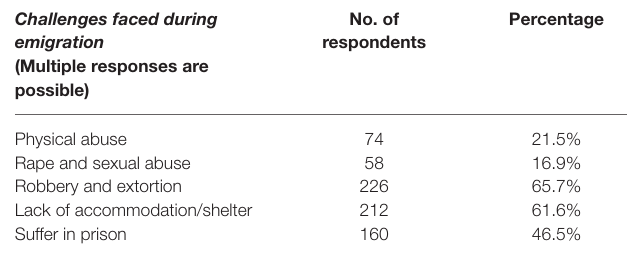
TABLE 2 | Challenges faced by female return migrants during emigration to the Middle East.